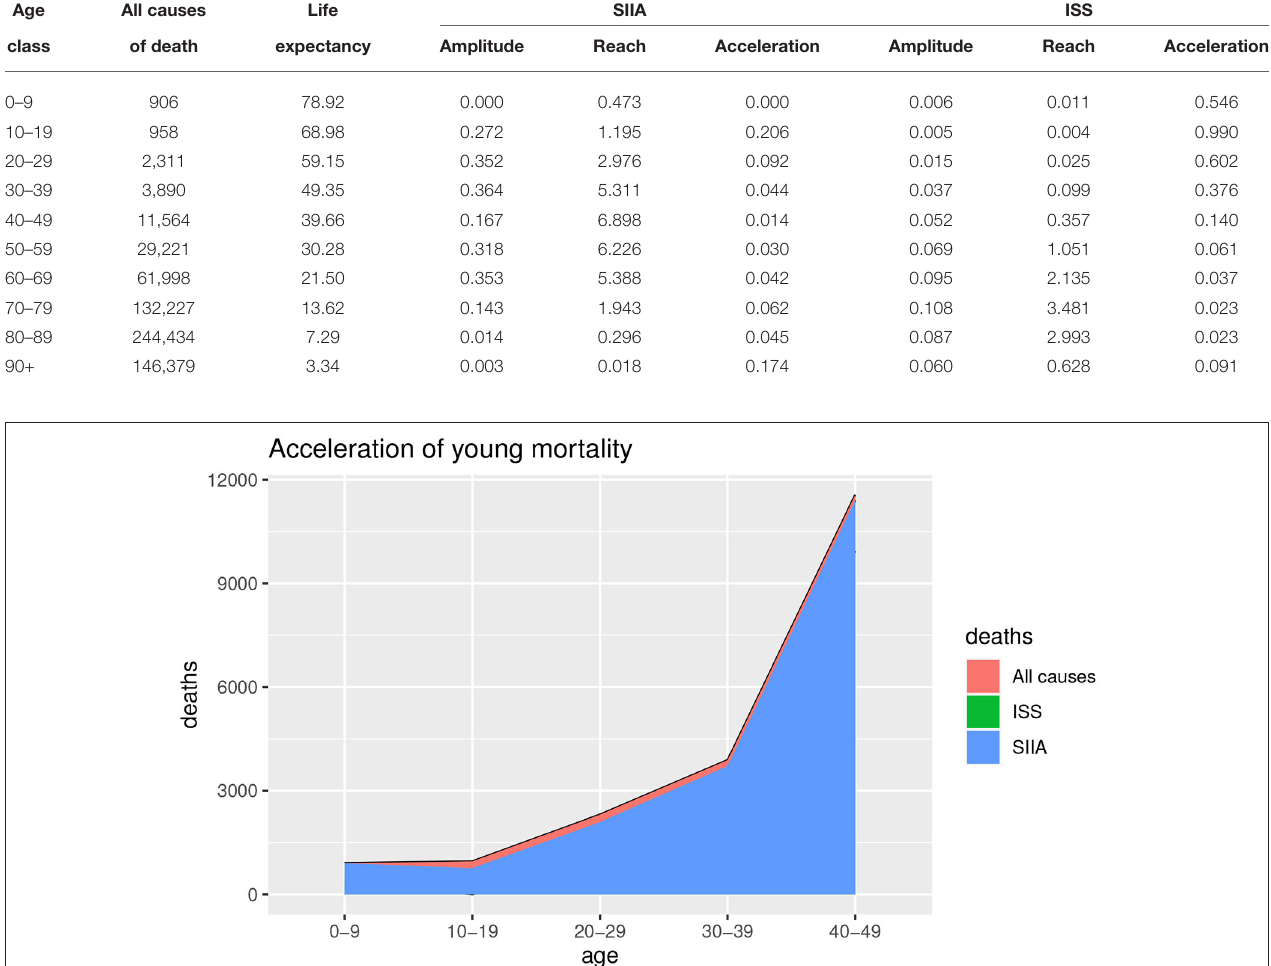
FIGURE 1 | Estimation of all causes of deaths and non-COVID-19 deaths. Young